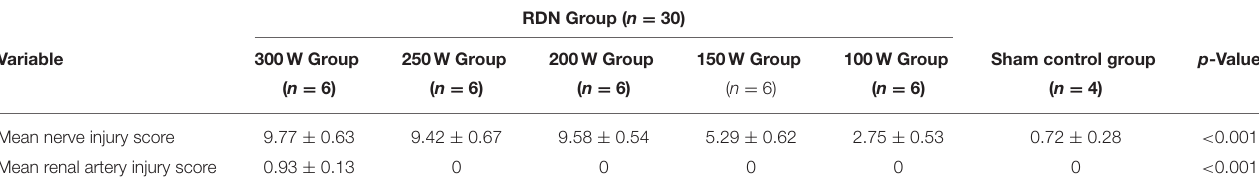
TABLE 4 | Comparison of mean nerve and renal artery injury score between groups at day 28.